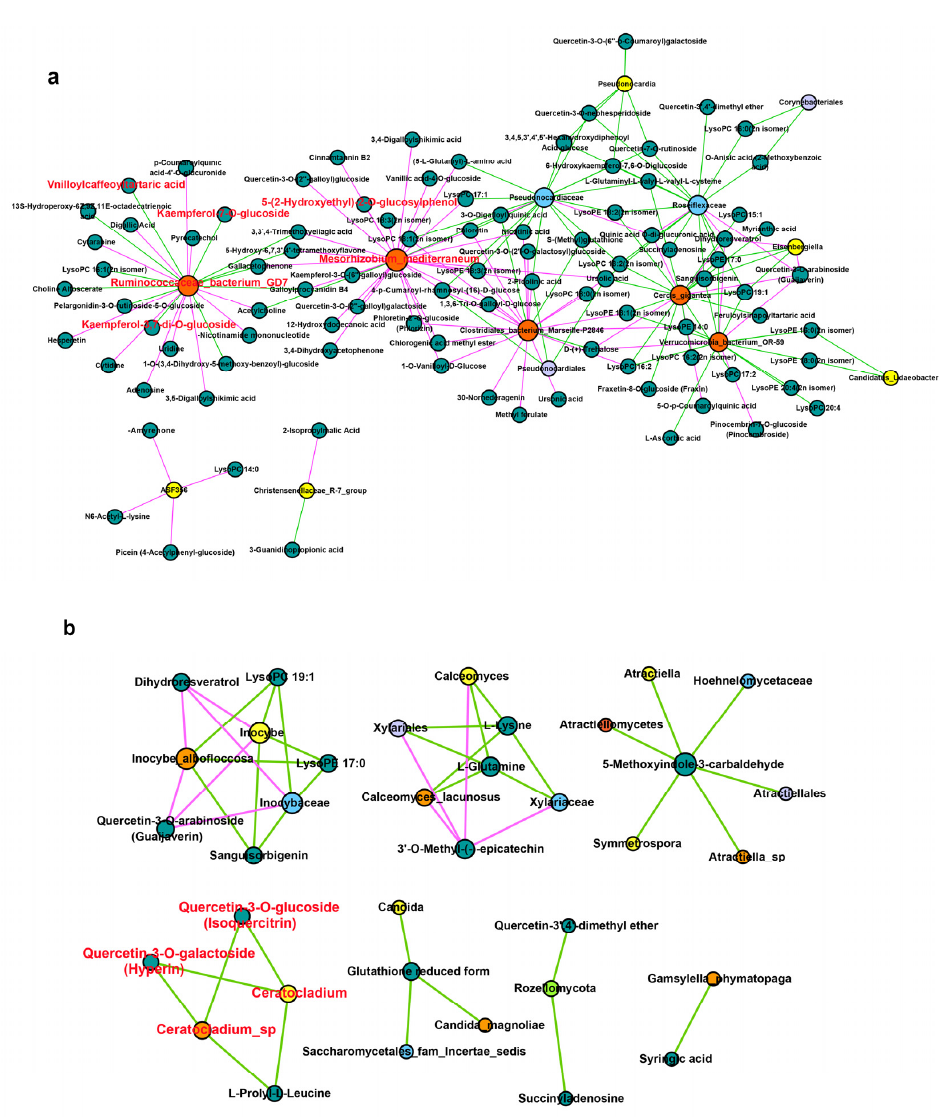
Figure 5. Correlation analysis of metabolome and microbiome. ( a ) Correlation analysis between metabolites and bacteria, p < 0.05. ( b ) Correlation analysis between metabolites and fungi, p < 0.01. Metabolites are shown in a green circle, yellow circle shows genus, lavender circle shows order, orange-red circle shows class, blue circle shows family, orange circle shows species, and light green circle shows phylum. The positive correlation is shown by the red line, the negative correlation is shown by the green line, and the size of the circle indicates the size of